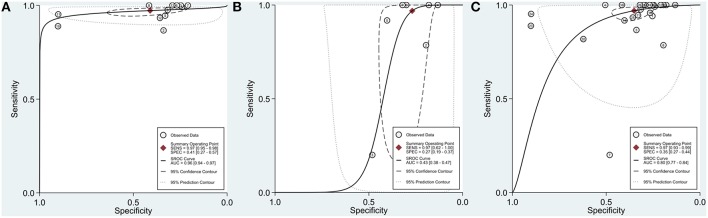
Summary receiver operating characteristic (SROC) curves. (A) Compensated advanced chronic liver disease (with an LS cut-off of 10 kPa). (B) Compensated advanced chronic liver disease (with an LS cut-off between 10 and 15 kPa). (C) Compensated chronic liver disease. AUC, area under the curve; LS, liver stiffness; SENS, sensitivity; SPEC, specificity.